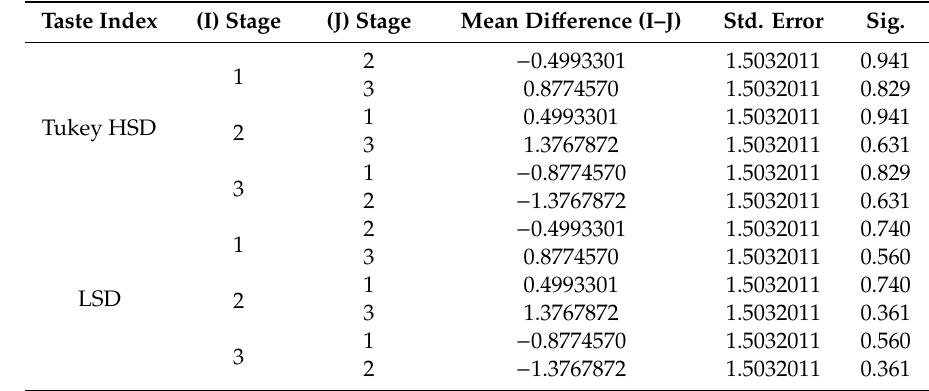
Table 6. Tukey and LSD comparing for property of taste index.